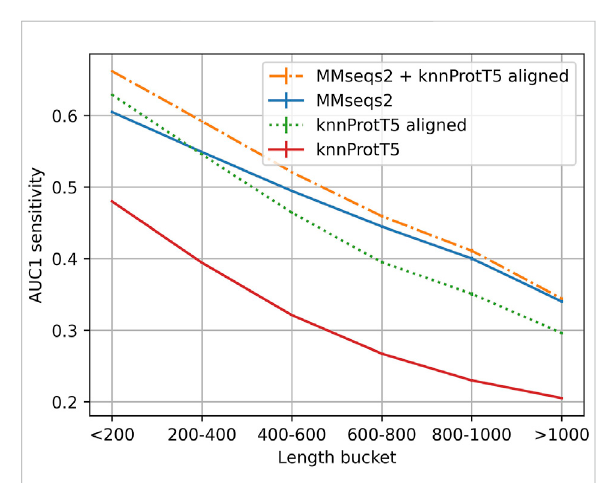
FIGURE 3 Longer proteins more dif fi cult for Pfam20. Mean AUC1 sensitivity for different bins of lengths (number of residues) for the query protein (full proteins, not just domains compared to Pfam regions), showing how the combined method works acrossdifferentsequencelength.Forthosefull-lengthproteins,all methods performed better for shorter than for longer proteins, e.g., MMseqs2 performance was almost half for proteins shorter than 200 residues than for those longer than 1,000 residues, and still substantially better for proteins with < 600 residues that account for the majority of UniProt. Long proteins are often contain multiple domain which have more total homologs on average and are also more dif fi cult to match on per-protein representation level